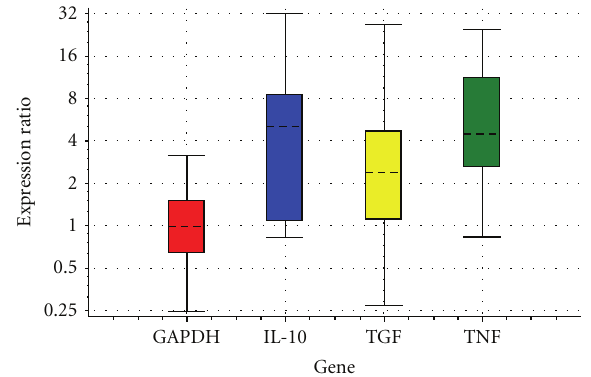
Figure 2: Relative expressions of IL-10, TGF- β 1, and TNF- α obtained from ginseng versus control after processing RT-PCR with REST in 20th